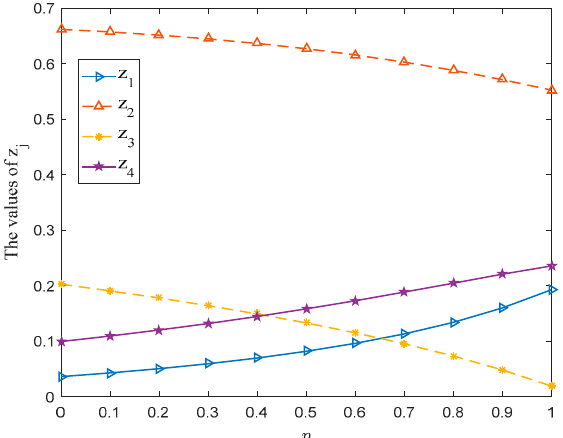
Figure 12. z j with parameter η varying from 0 to 1.